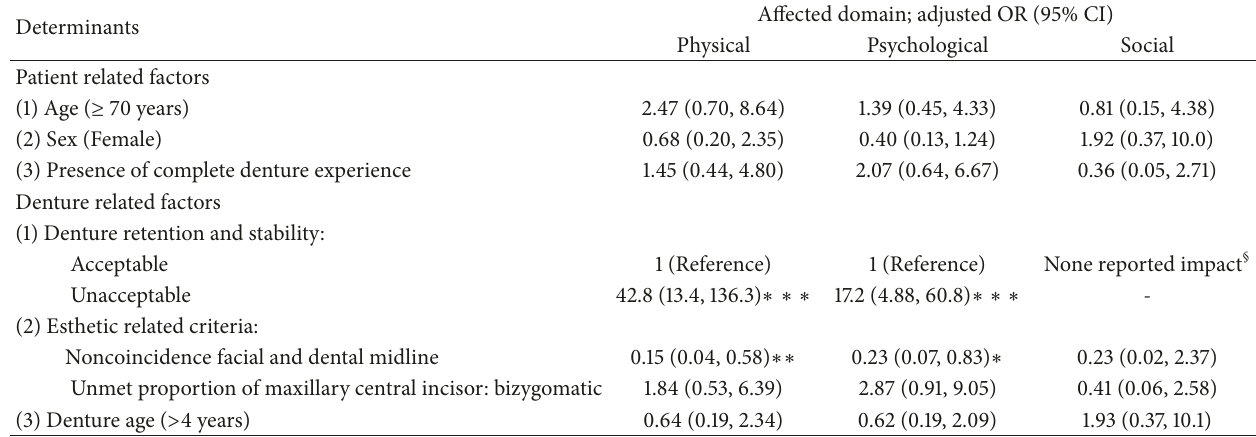
Table 4: Adjusted odds ratio (95% CI) from multivariable analyses of oral impact domains.